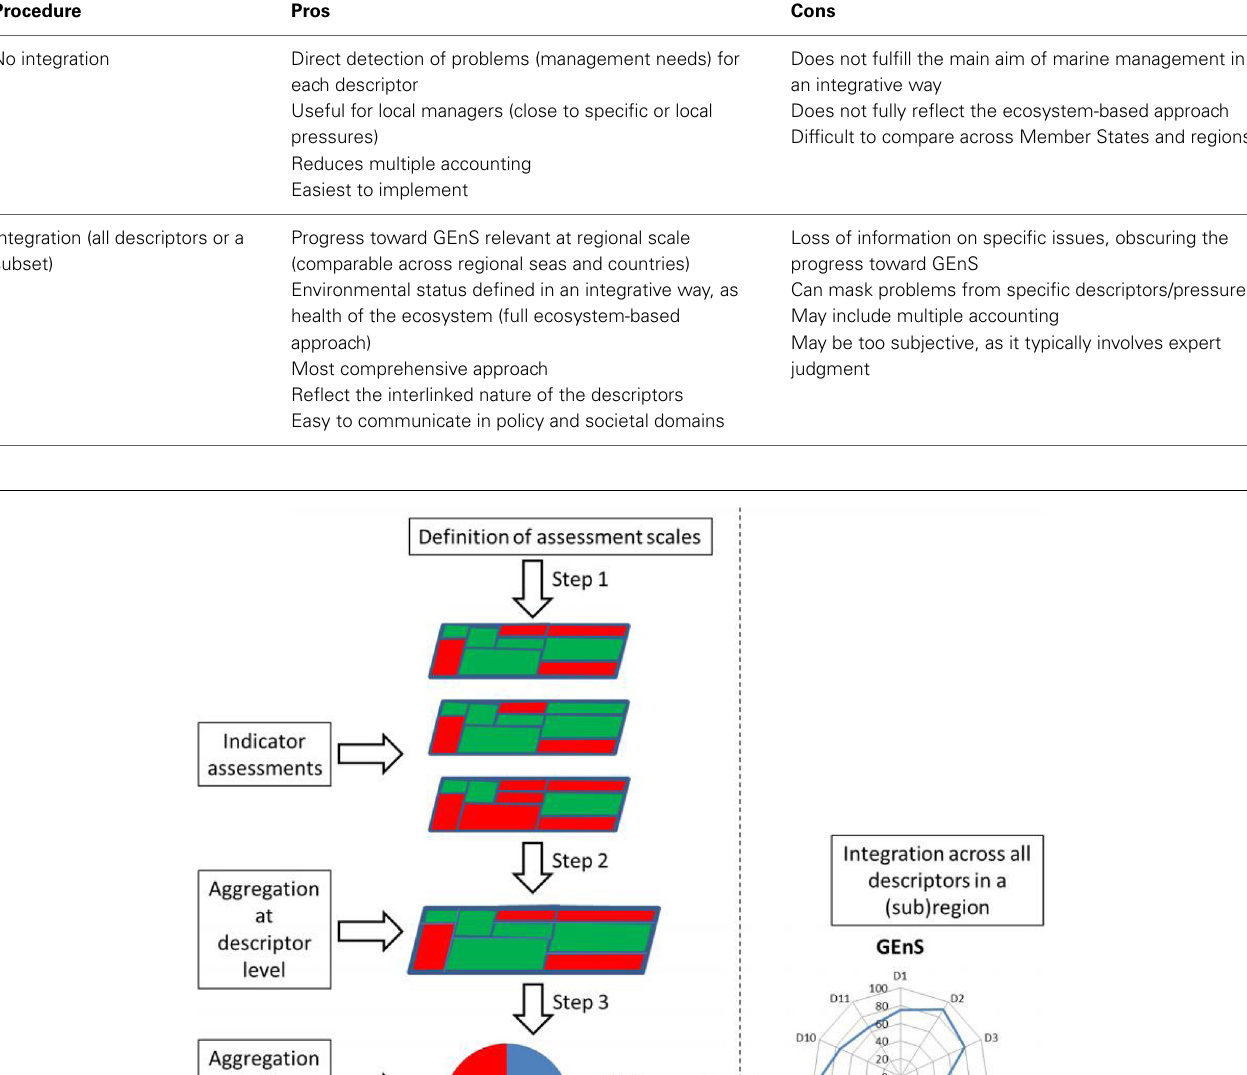
level can be aggregated to assessments at descriptor level